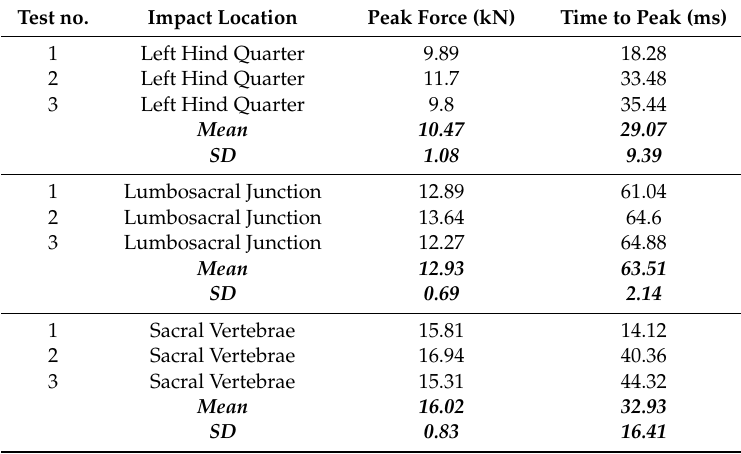
Table 2. Un-helmeted drop test results for horse